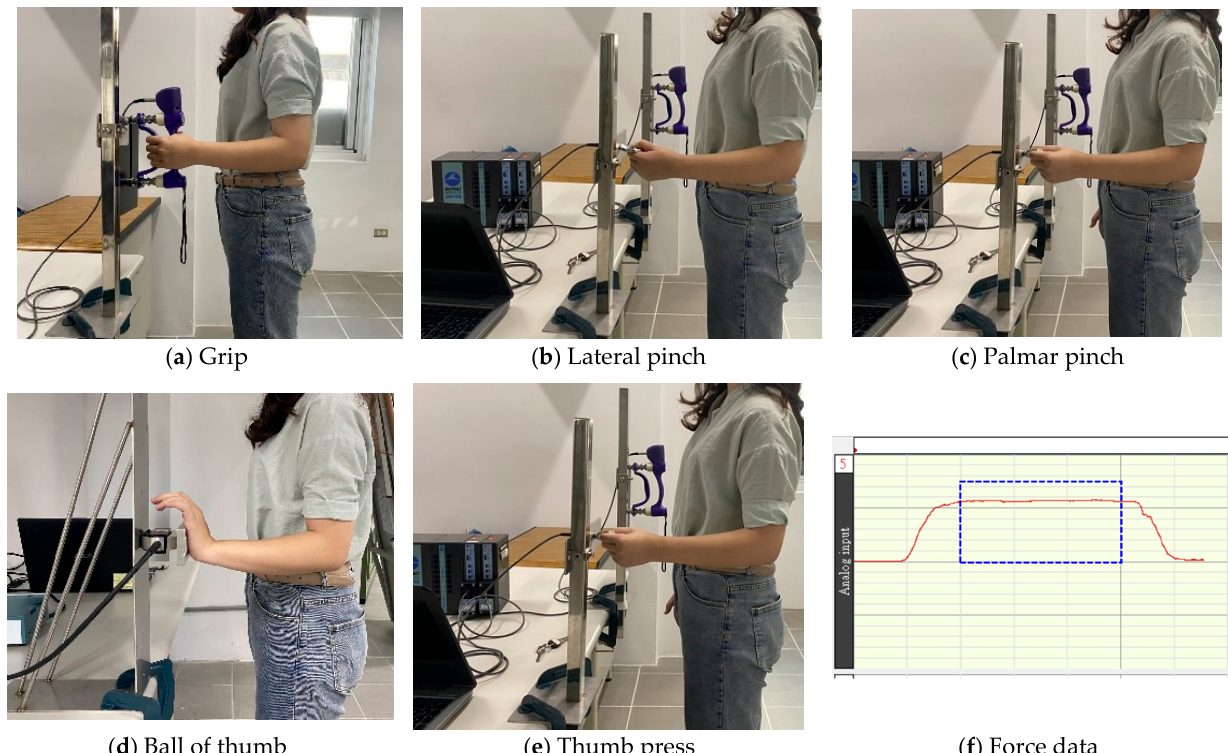
Figure 1. Illustrations of five types of hand movement and 5-s force data. ( a ) Grip; ( b ) Lateral pinch; ( c ) Palmar pinch; ( d ) Ball of thumb; ( e ) Thumb press; ( f ) Force data.